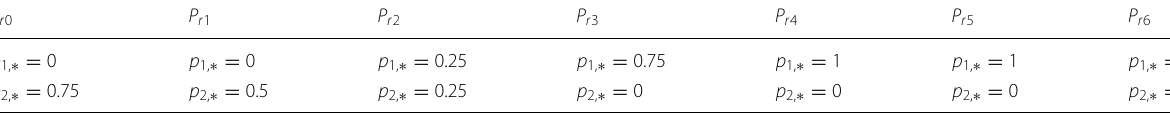
Table 2 Statistical data based assignment of transition probability values for the case